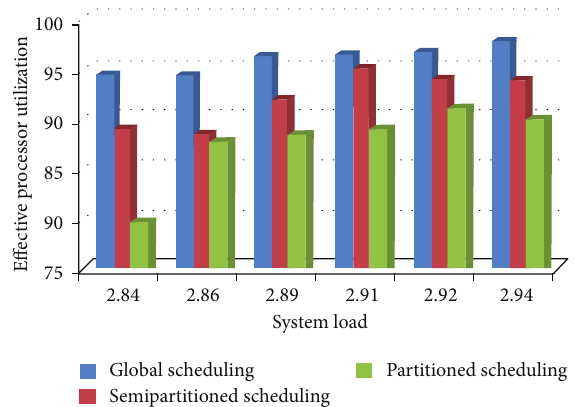
Figure 11: Comparison of effective processor utilization for different scheduling techniques.